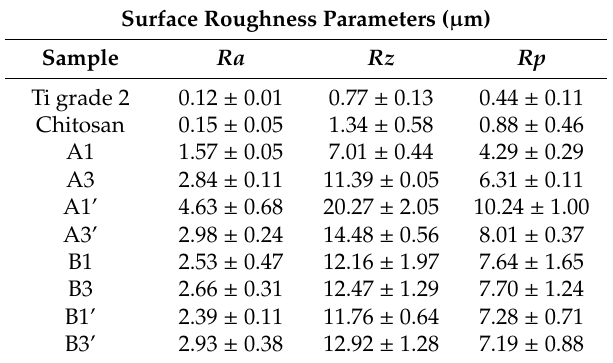
Table 3. Surface roughness parameters of the Ti grade 2 substrate, the chitosan coating, and the chit / EE100 coatings (mean ± SD; n =